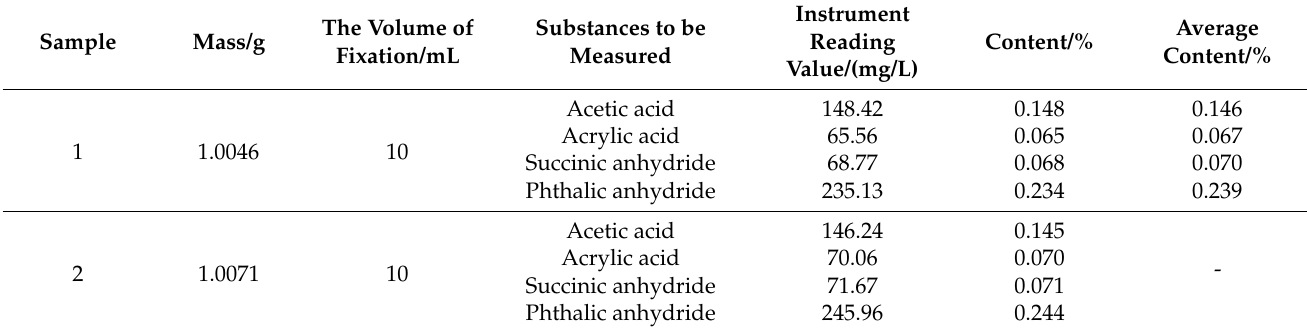
Table 6. Quantitative analysis of high-temperature pyrolysis